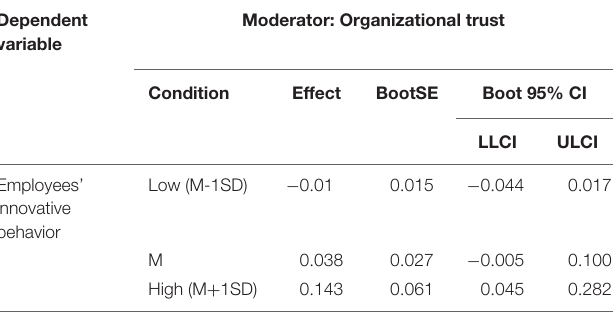
FIGURE 3 | Interaction of organizational identification and organizational trust on the innovative behavior of